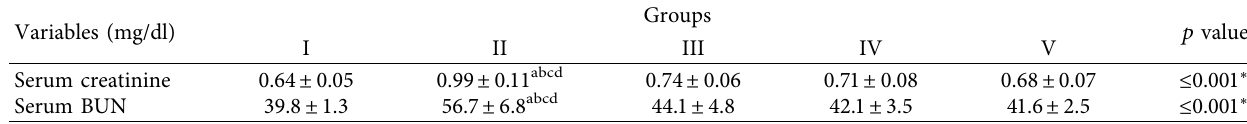
Table 1: Serum creatinine and BUN levels of mice.